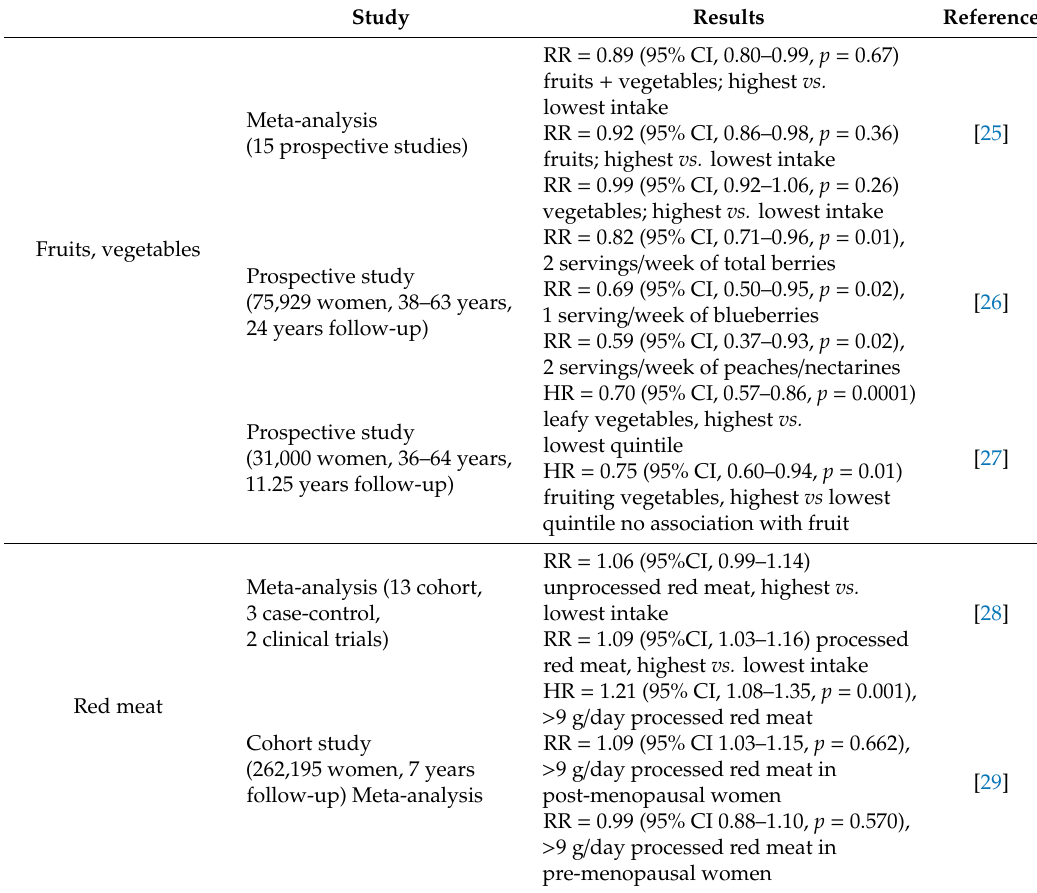
Table 1. Possible e ff ects of dietary factors on BC